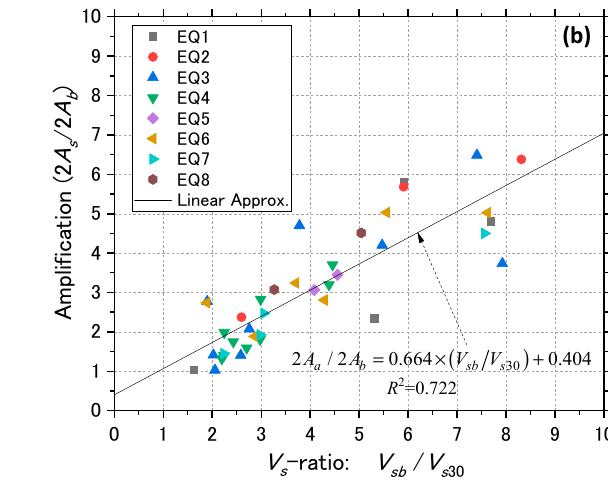
Figure 12. Site amplification 2 A s /2 A b of eight earthquakes EQ1-E8 plotted versus V sb / V s ( a ) and V sb / V s 30 ( b